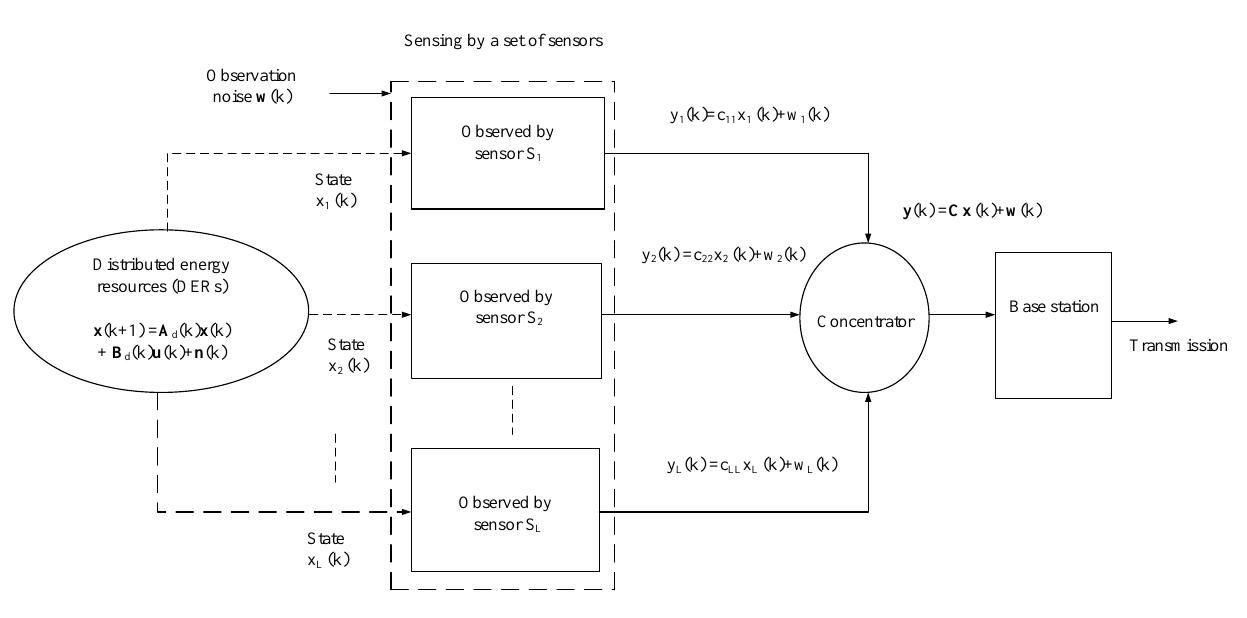
Figure 7. A linear decentralized WSN based DER monitoring system.